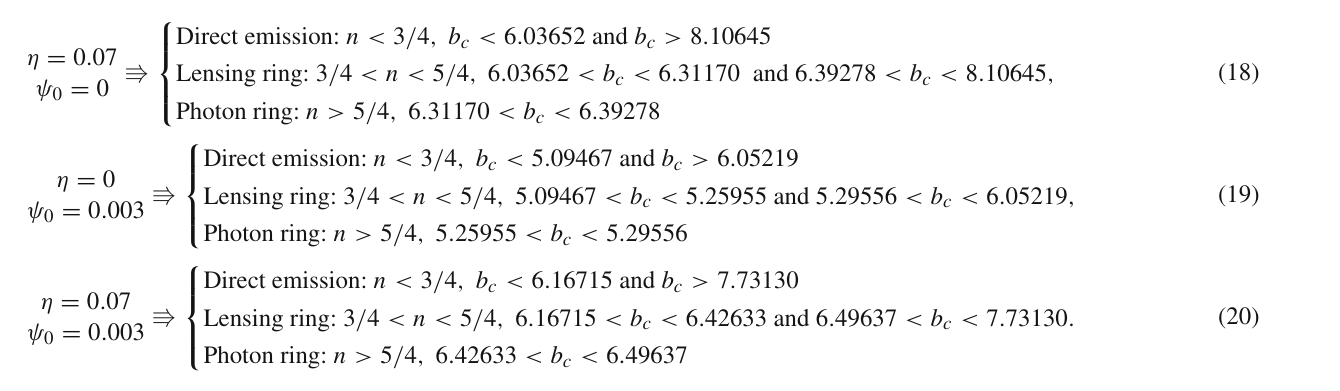
for different values of n . They are direct emission, lensing ring and photon ring respectively, which correspond to n < 3 / 4, 3 / 4 < n < 5 / 4 and n > 5 / 4. And, the corresponding trajectories of light rays will intersect with the equatorial plane once, twice and more than twice, respectively. For a f ( R ) black hole with the global monopole, we have taken the following choice of η and ψ 0 as the examples to present the regions of direct emission, lensing ring and photon ring in Eqs. (18)–(20).